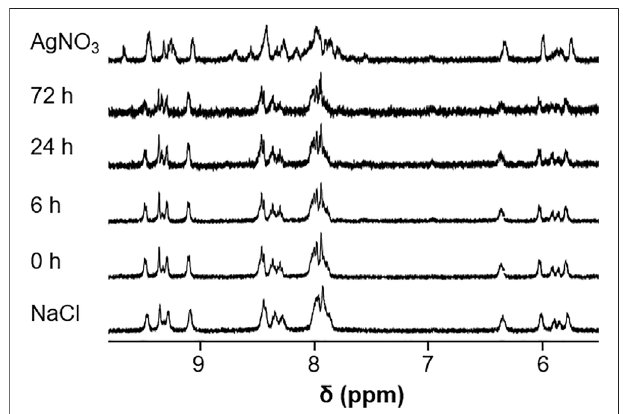
FIGURE 6 | 1 H NMR spectra of complex 2f recorded in 10% DMSO- d 6 / D 2 O over a period of 72 h as well as after addition of AgNO 3 (2 equiv.) or NaCl (100